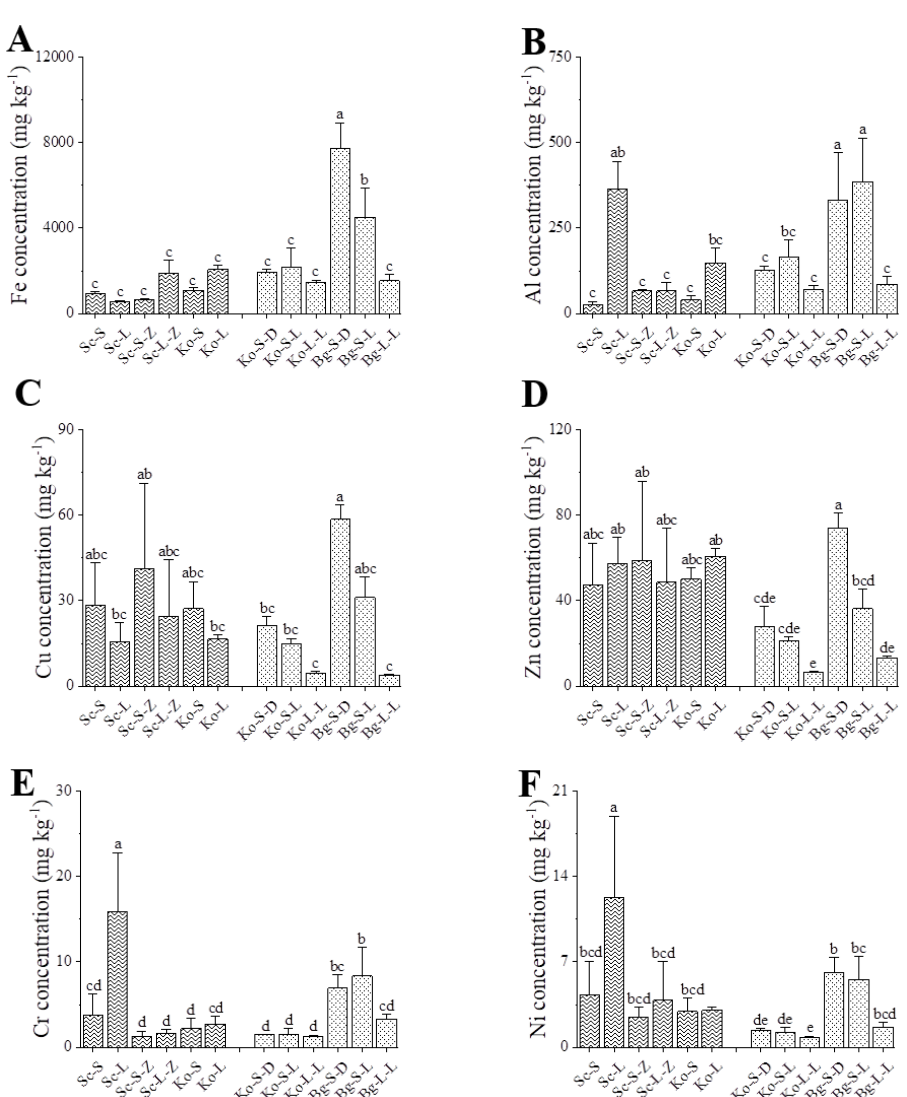
Figure 3. Concentrations of Fe ( A ), Al ( B ), Cu ( C ), Zn ( D ), Cr ( E ), and Ni ( F ) from mangrove plant samples in the K. obovata and S. caseolaris communities on the west coast of Bao ’ an, Shenzhen. Mean ± SD of three replicates were shown. Different small letters indicate significant differences among the concentrations of Fe, Al, Cu, Zn, Cr, and Ni in the leaves or stems from Sc, Ko, and Bg at p < 0.05. The note is the same as in Figure 2 .